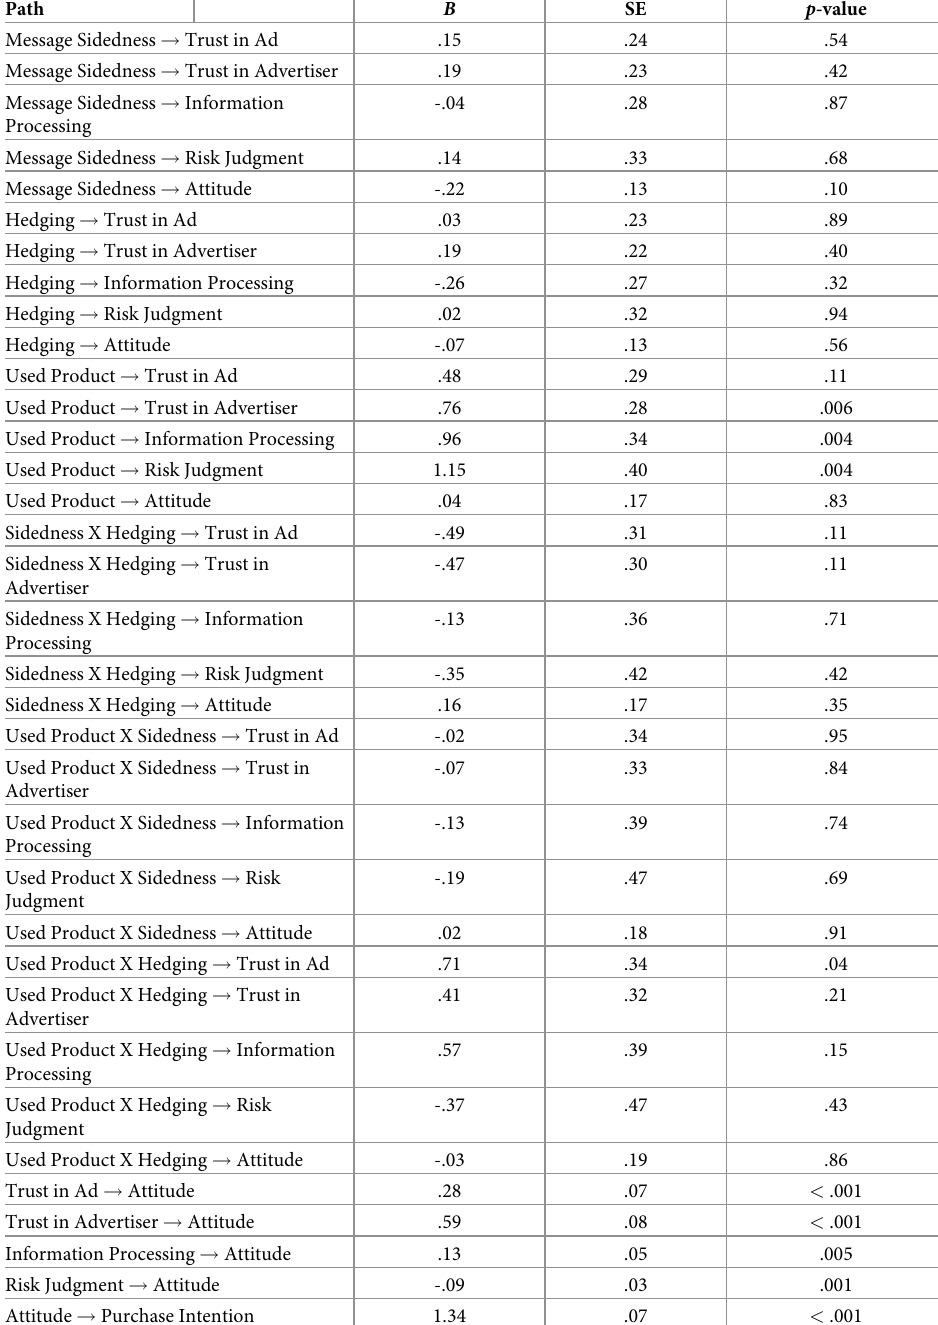
Table 2. Final estimates of the path analysis